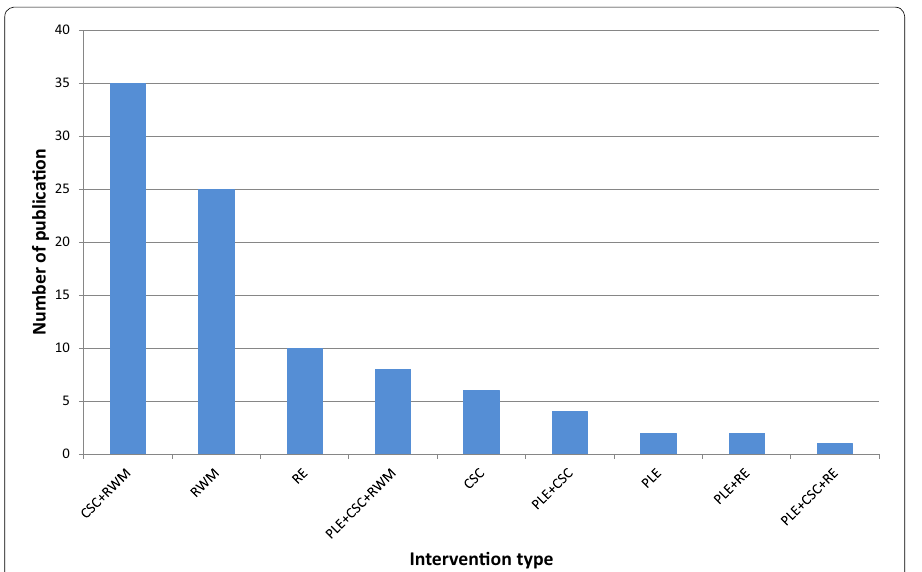
Fig. 2 Number of publications per circularity intervention category (status on 11 June 2018). RWM residual waste management, CSC closing supply chains, PLE product lifetime extension, and RE resource